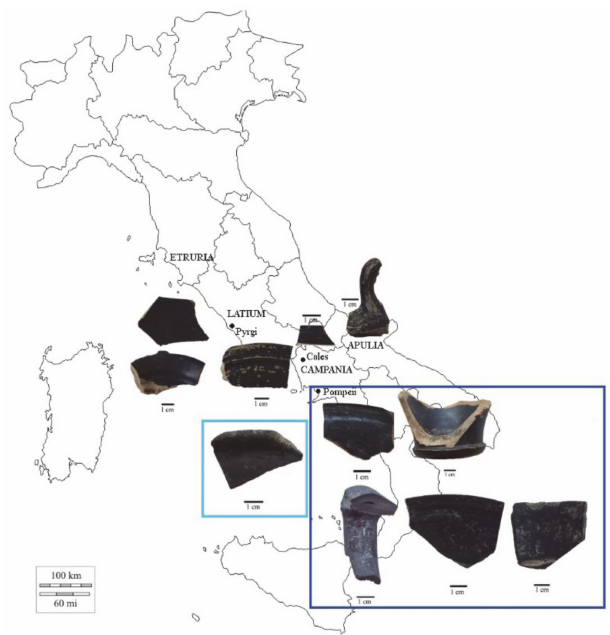
Figure 6. Map showing the probable areas of provenance suggested by the results of this